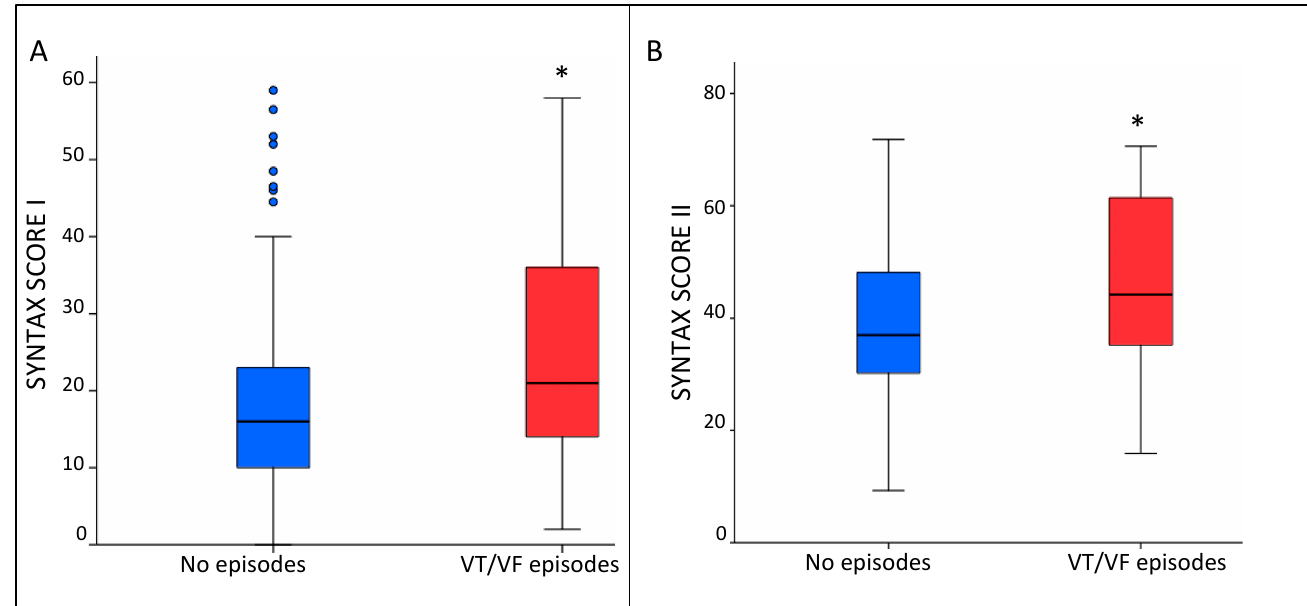
Figure 2. Whisker plots showing the relation between SS I ( A ) and SS II ( B ) in patients who experienced VT/VF episodes and in those who did not. The symbol “*” represents a significant p value < 0.05; the symbol “ ◦ ” represents an outlier. Table 2. Univariate analysis and multivariate analysis 1 (MV1) including SS I and multivariate analysis 2 (MV2) including SS II. Statistical significance between VT/VF episodes occurrence and SS II was always observed even after adjustment for all the covariates; panel C shows the best fitting regression model.